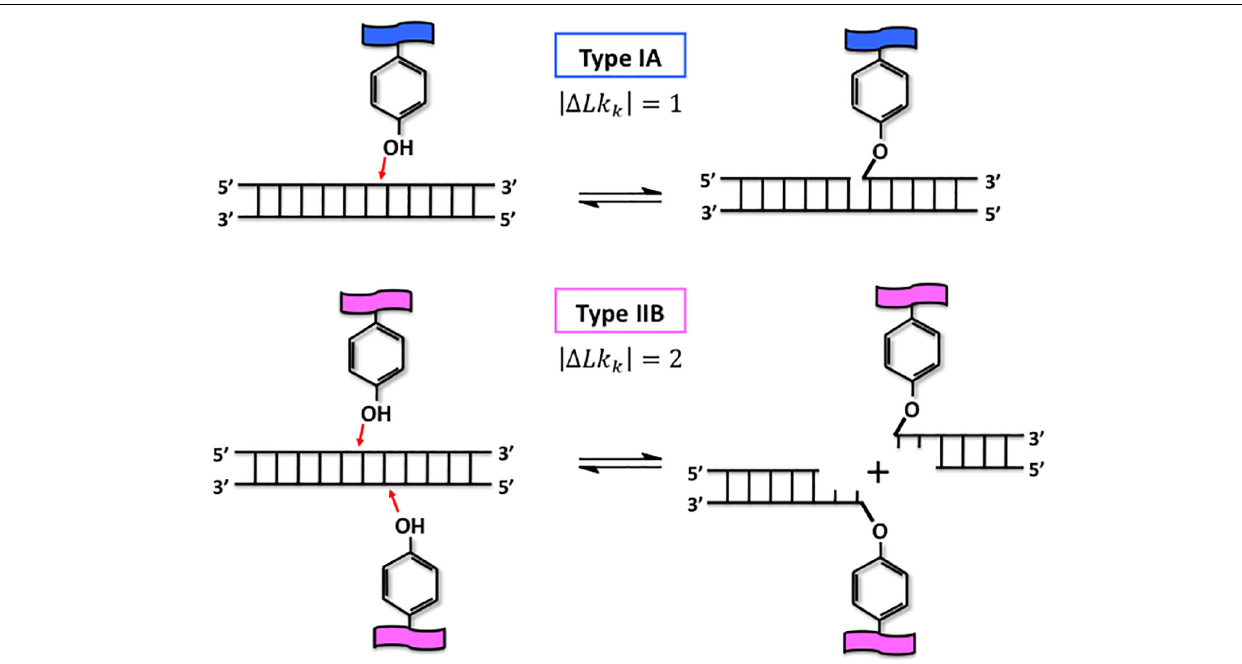
FIGURE 3 | The magical power of DNA-topoisomerases: the transesterification reaction. Type IA and type IIB DNA-topoisomerases are represented by the tyrosine group, which is characteristic of their active site, in presence of double-stranded fragment of DNA (upper and lower parts, respectively). The transesterification reaction performed by type I and type II DNA-topoisomerases can be divided into three major steps. First, the tyrosine group attacks the phosphate group of the DNA backbone orientated 5’–3’, which is represented by red arrows (left part). Second, type IA, and type IIB DNA-topoisomerases transiently cleave one or two strands of DNA, respectively, by being covalently linked to the phosphate group at the 5’ extremity (right part). The double black arrow symbolizes the dynamics which exists between these two steps. The passage of one or two strands of DNA through the DNA break is performed by type I and type II DNA-topoisomerases, it occurs during the open state. After resealing the gate by reverting the reaction shown, the linking number of the DNA molecule is changed by one or two,